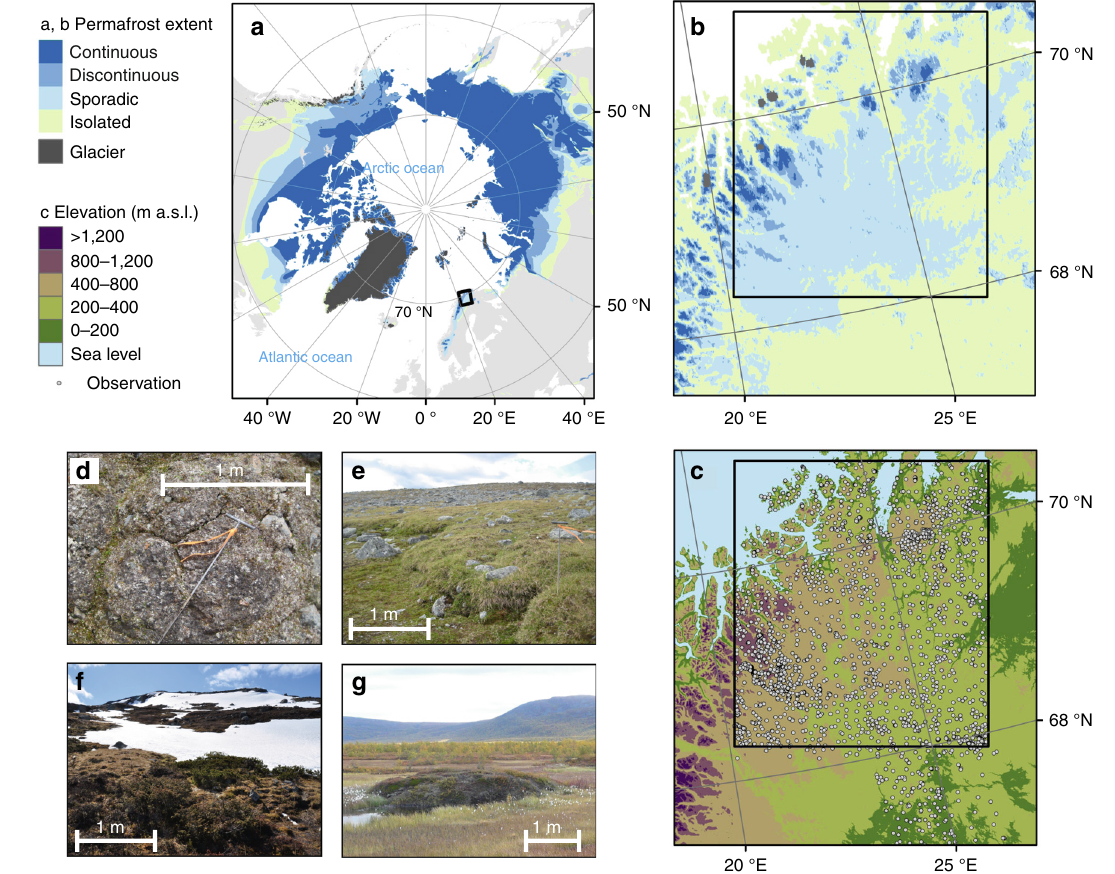
Fig. 1 The location of the study domain and LSP observation sites in northernmost Europe. a , b The study area in relation to the circum-Arctic extent of permafrost 23, 24 indicated as: continuous = 90 – 100% of the area covered by permafrost, discontinuous = 50 – 90%, sporadic = 10 – 50% and isolated = 0 – 10%, respectively. c The observation locations ( n = 2,917) and the relief of the study area. Black rectangles in b , c depict the model prediction domain. Photos show examples of typical surface features of cryogenic land surface processes (scales are only directive): cryoturbation ( d ; small-scaled polygonal patterned soil) geli fl uction ( e ; geli fl uction lobes), nivation ( f , snow accumulation sites) and permafrost mounding ( g ; palsas), respectively. Photos by J.A. and